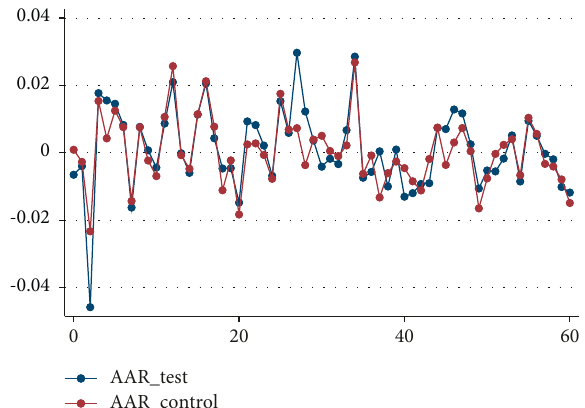
Figure 2: Average abnormal returns of the test group and the control group. Note. This figure gives the average abnormal return for the test group and the control group in the subsequent 60 trading days. The red line and blue line represent the average abnormal returns of the test group and the control group, respectively.